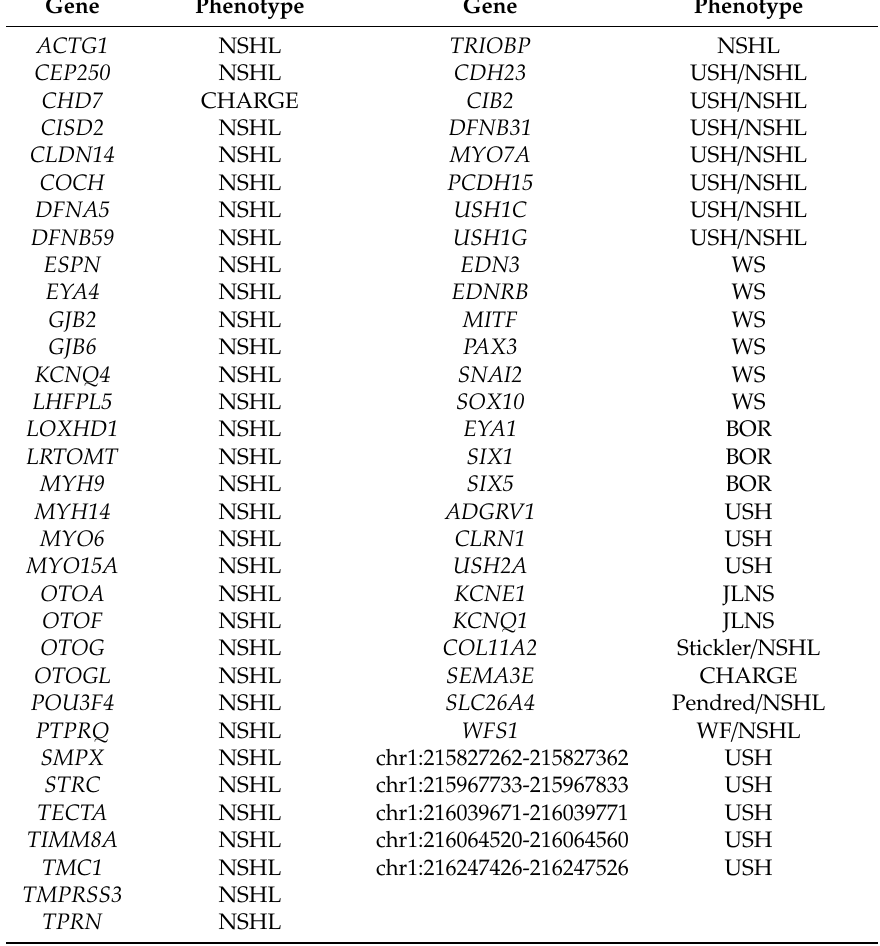
Table 1. The Table Indicates the Genes Included in this Study and the Associated